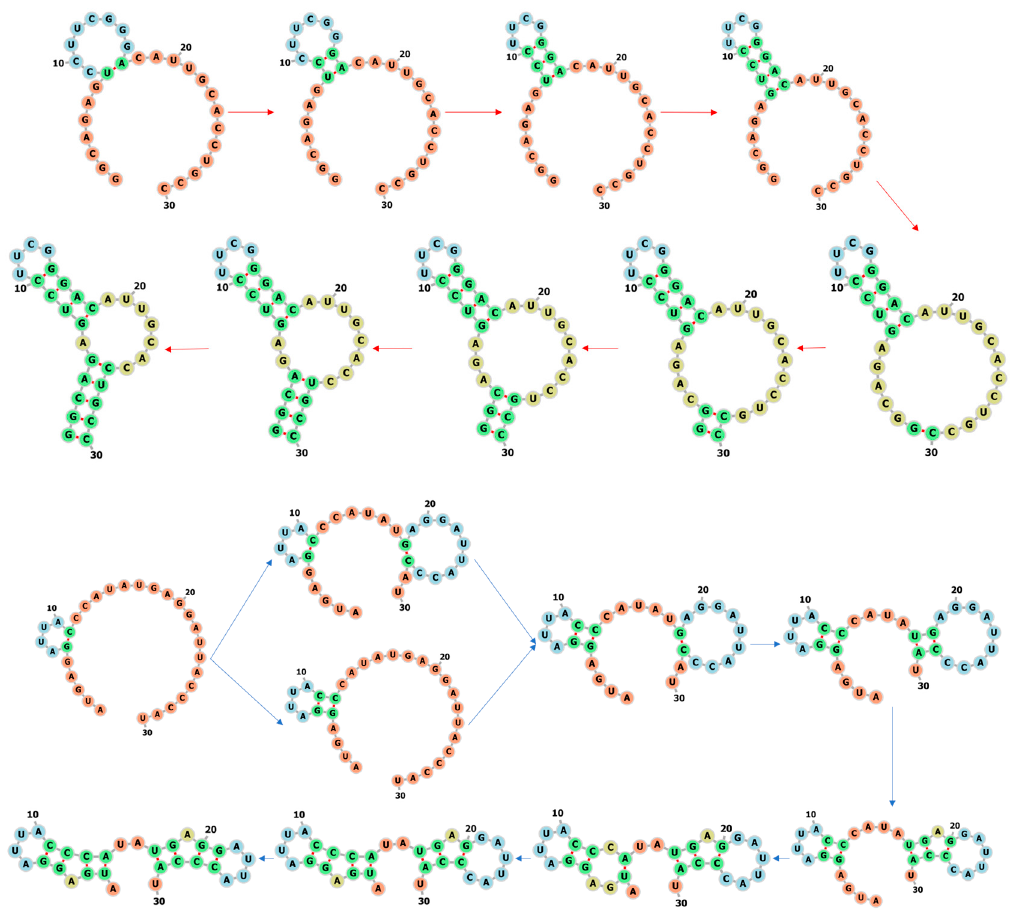
Figure 6. The prediction results of the fastest folding paths of two RNA molecules, PDB_00312 ( top ) and PDB_01136 ( bottom ).